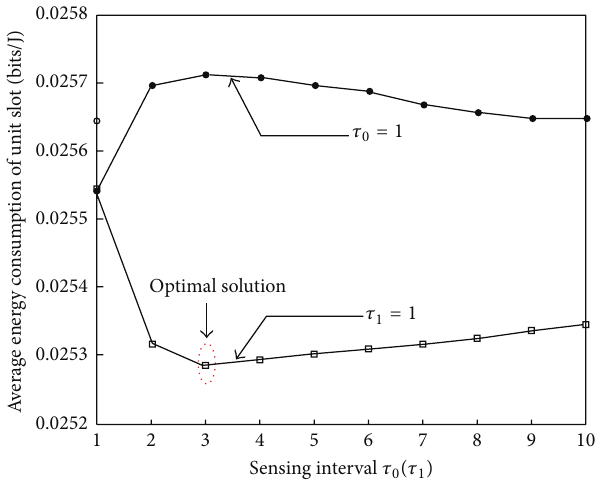
Figure 5: Average consumption in a unit slot with different combination of (𝜏 0 , 𝜏 1 ) .